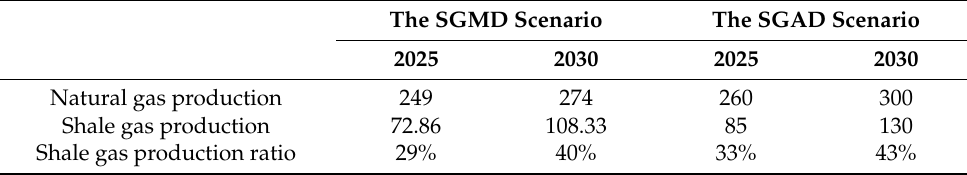
Table 2. Shale gas production and proportion in different scenarios; Unit: billion cubic meter.